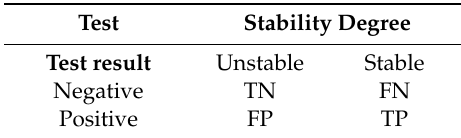
Table 1. Matrix table for the comparison of landslide-susceptibility models (test results) and validation landslides (true condition).